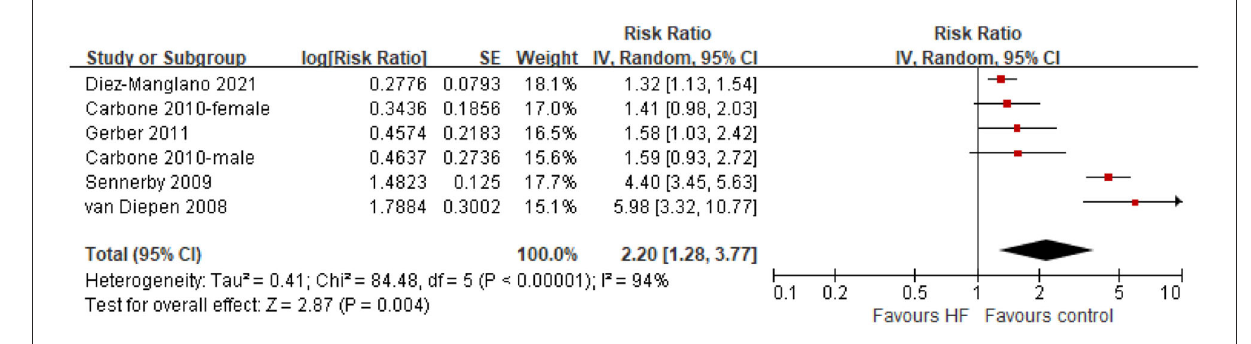
FIGURE3 Forest plot of comparison: HF vs. control, outcome: hip fractures. CI, confidence interval; HF, heart